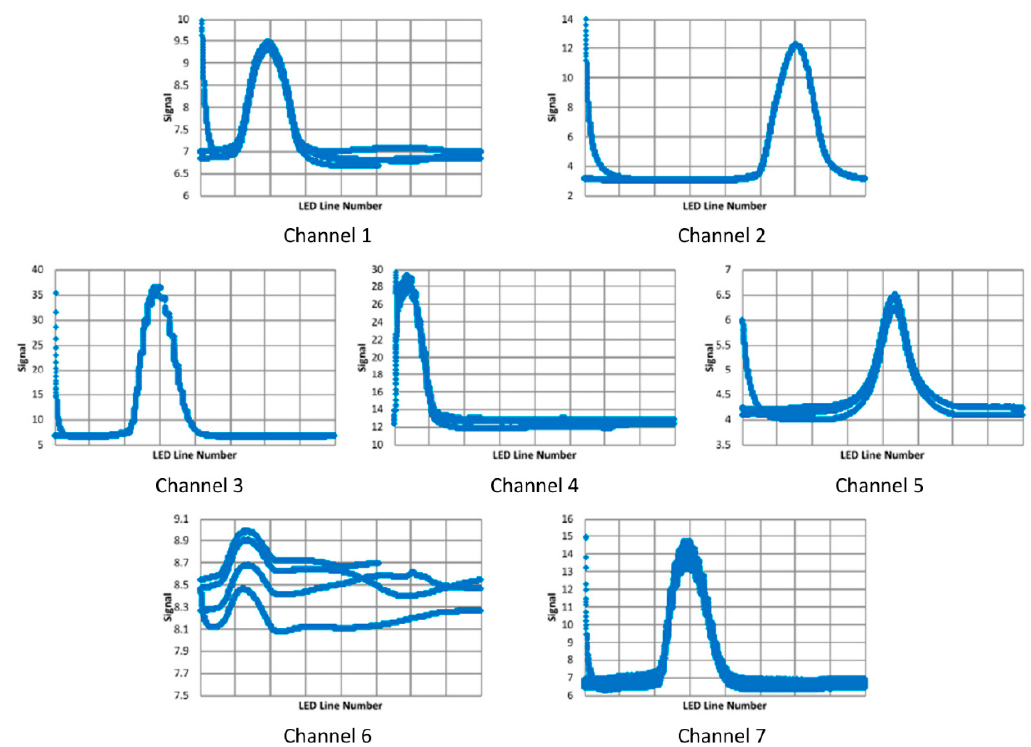
Figure 20. Quasi-Gaussian response signals (V) for each LED line (1–64) for the seven sensor channels for outdoor tests with the Orion 70 mm Multi-Use Finder Scope.